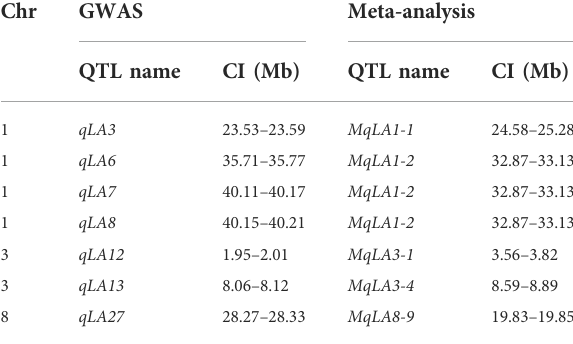
TABLE 3 List of co-located QTLs and physical position revealed by GWAS and meta-analysis. Chr